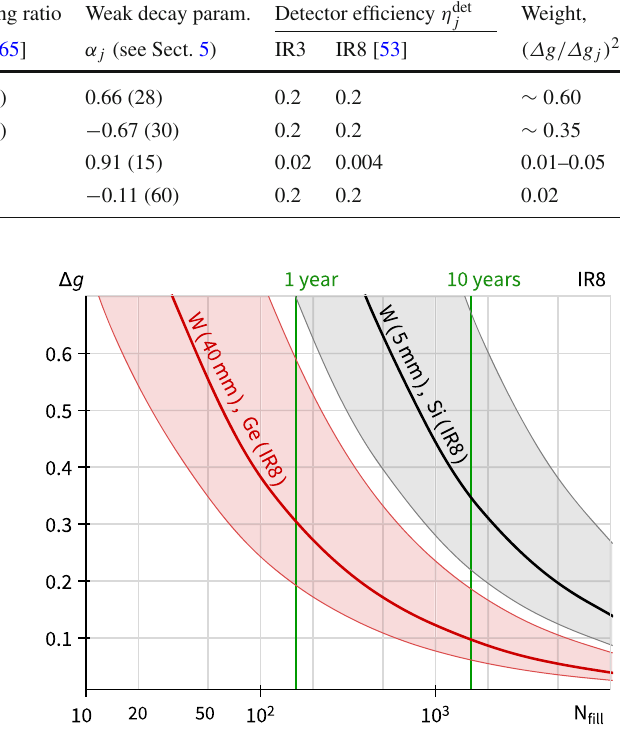
Fig. 8 Absolute statistical error of g -factor as a function of number of fills (left) for IR3 and (right) for IR8 configurations. Black curves for 5mm tungsten target attached to silicon crystal, red curves for 40mm